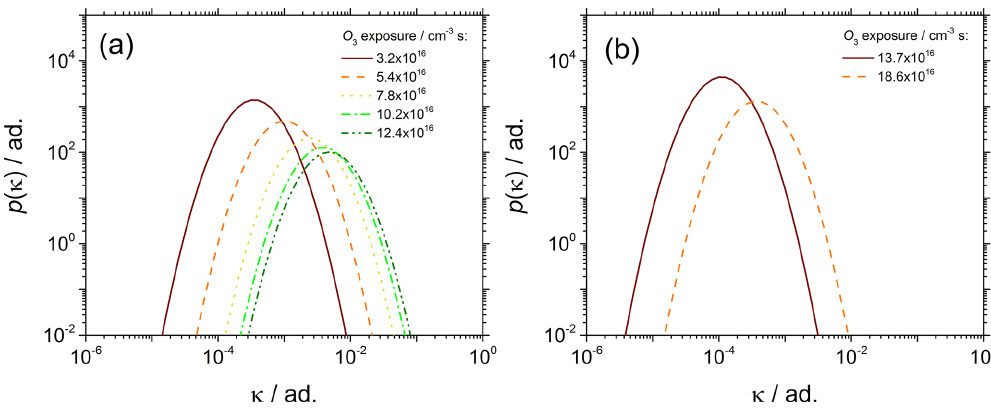
Figure 9. Evolution of p(κ) vs. ozone exposure of (a) young soot particles sampled at 70mm HAB and (b) mature soot particles sampled at 130mm